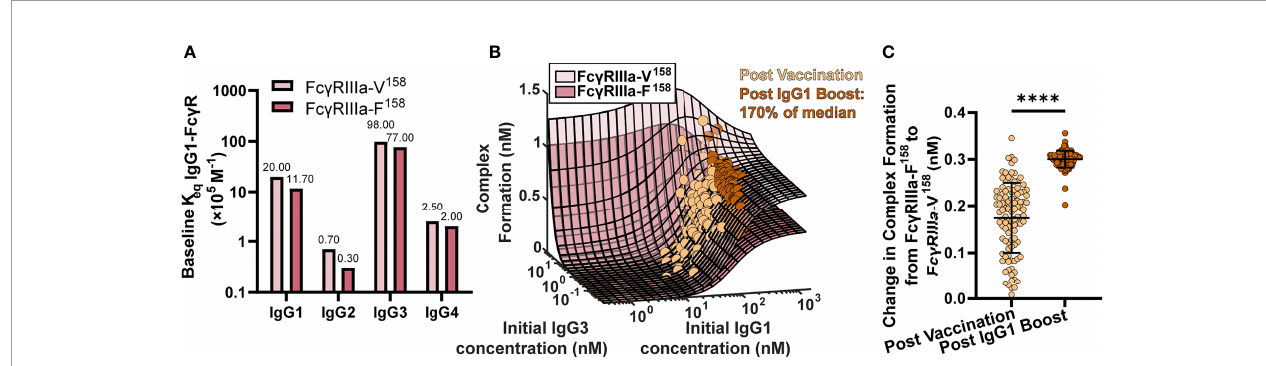
FIGURE 3 | Fc g R polymorphisms have a greater in fl uence on complex formation after IgG1 boosting. (A) Baseline K eq of each IgG subtype to the high af fi nity Fc g RIIIa-V 158 polymorphism (light pink) and the low af fi nity Fc g RIIIa-F 158 polymorphism (dark pink) as reported by Bruhns et al. (11). (B) Complex formation (z axis) predicted by the model for 2500 combinations of initial IgG1 and IgG3 concentration (x and y axes) for Fc g RIIIa-V 158 (light pink) and Fc g RIIIa-F 158 (dark pink). Each dot represents an RV144 plasma sample (n=105) with respective initial IgG1 and IgG3 concentrations plotted post-vaccination (baseline-light orange), and after a simulated 170% (145 nm) boost of IgG1 (dark orange). The simulated boost magnitude was estimated based on the highest fold change seen in RV306 between 26 weeks and peak HIV speci fi c IgG titer (2.64X in arm 4b) (31). (C) The difference in complex formation predicted between the Fc g RIIIa-F 158 and Fc g RIIIa-V 158 polymorphisms post-vaccination (light orange) and post-IgG1 boost (dark orange; Wilcoxon matched-pairs signed rank test; ****p-value <